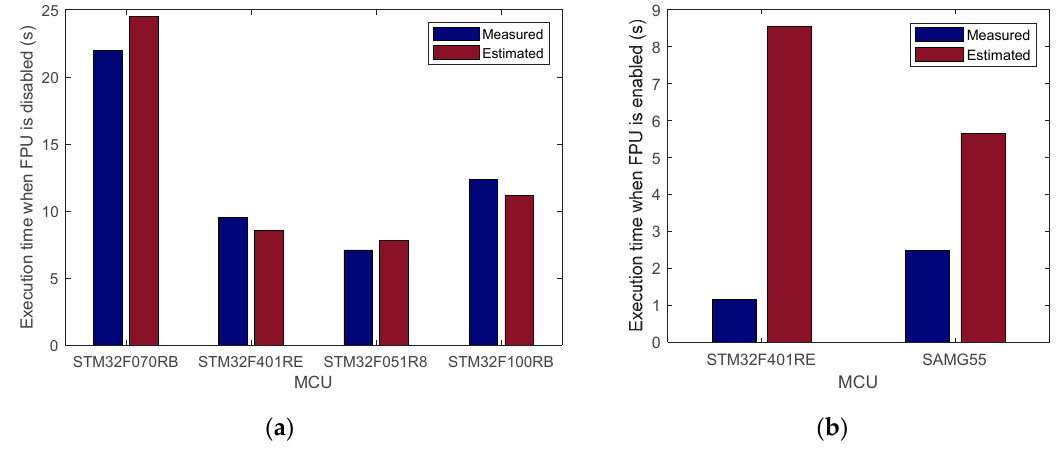
Figure 4. Processing-time estimation using the CM / MHz figure ( a ) when the FPU is disabled and ( b ) when it is enabled.